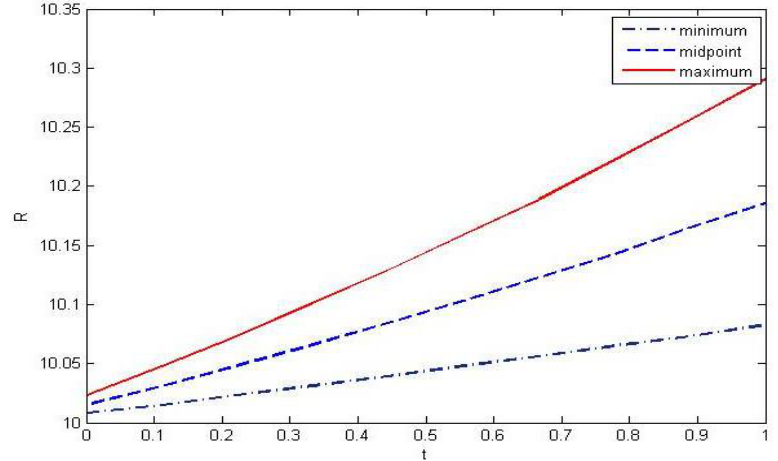
Figure A2. Plot of the maximum, center, and minimum of infected humans under the intervals (cid:2010)(cid:3560) = [0.01,0.03] and (cid:2011)(cid:3556) = [0.01,0.015] .